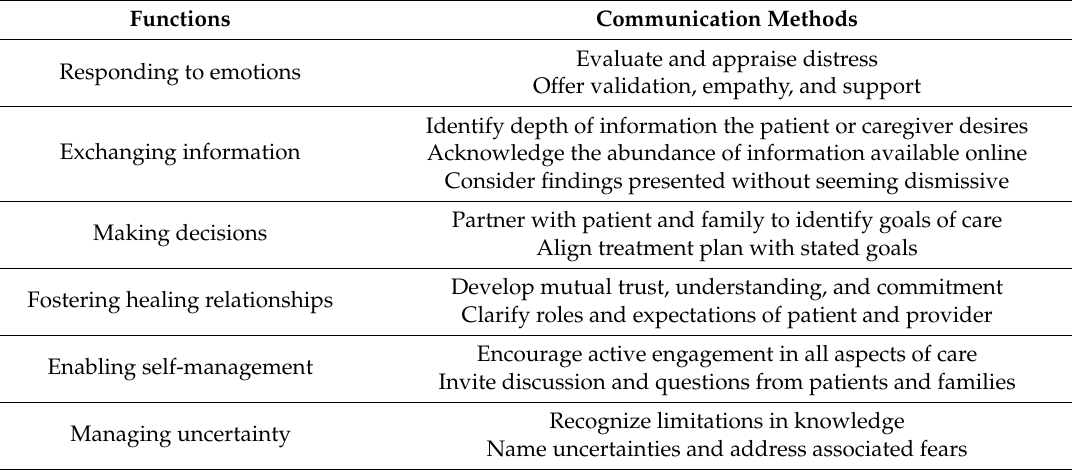
Table 1. Six core functions of patient–provider